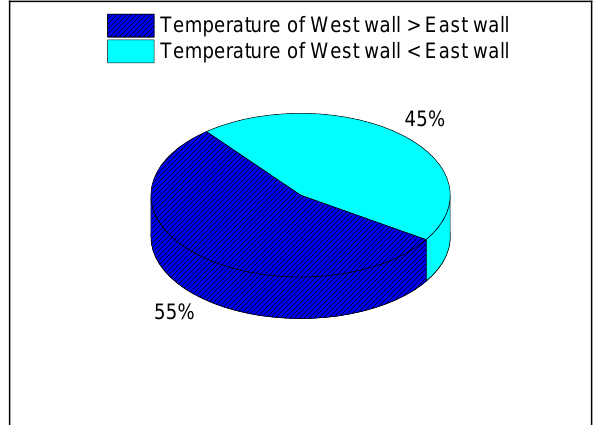
Figure 9. Percentage in comparison of temperatures between west wall and east wall.